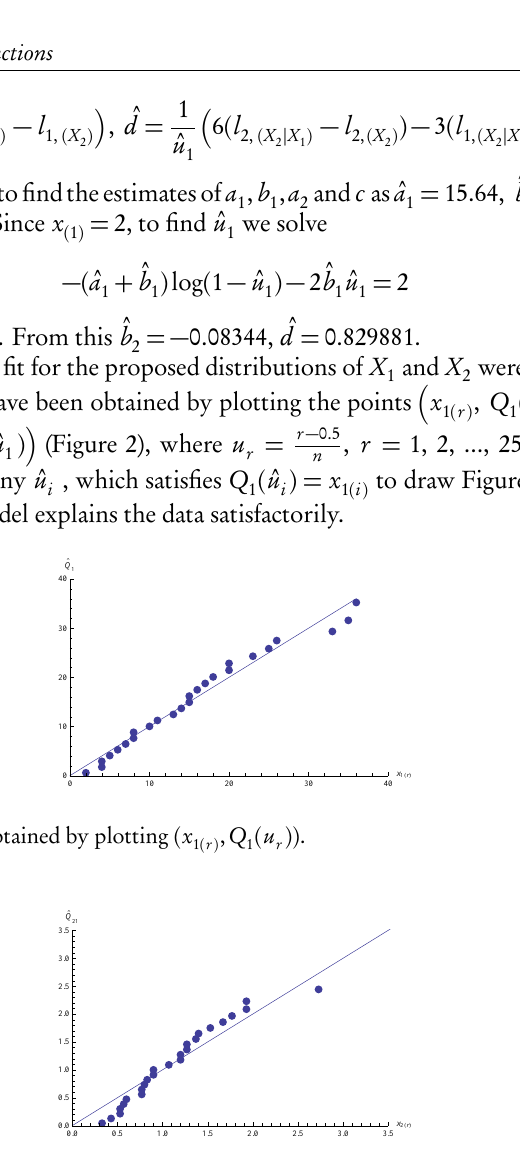
( u ) | ˆ u ) , Q 2 ( r ) 21 1 r